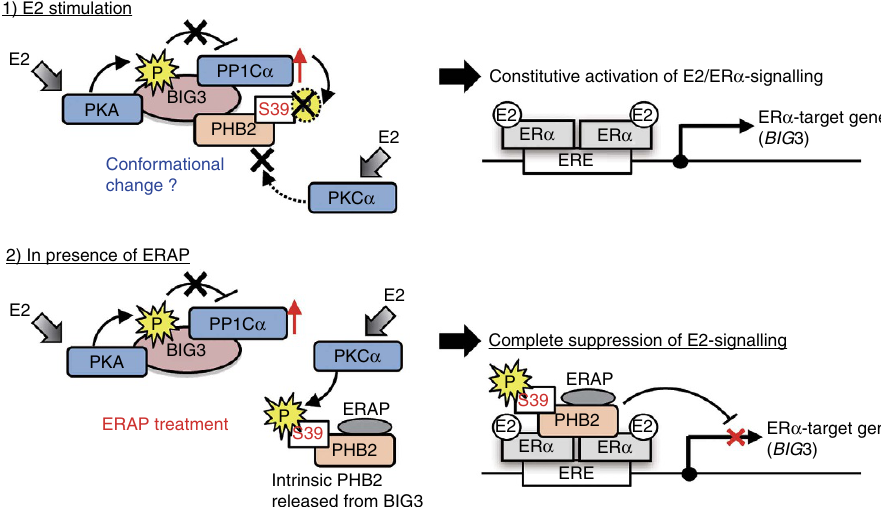
Figure 5 | Schematic illustration of the novel mechanism of PHB2 inactivation through the BIG3–PKA–PP1C a tri-complex, in breast cancer cells. Upper, E2 stimulation induces PKA-dependent BIG3 phosphorylation, which cancels its negative regulation of PP1C a activity, resulting in the avoidance of PHB2 suppressive activity and PKC a approach. Lower, ERAP treatment induces PHB2 release from BIG3, continuously inducing PHB2 phosphorylation via PKC a and resulting in the complete suppression of ER a signalling